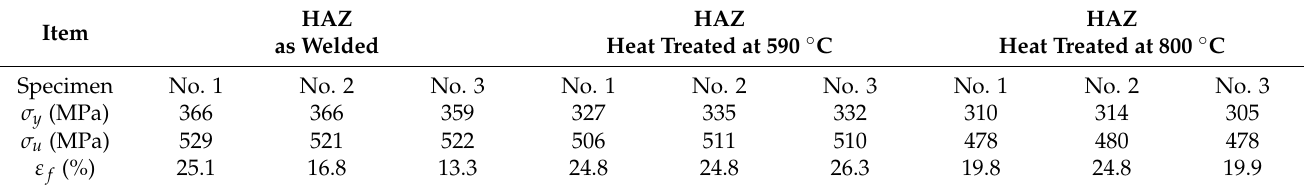
Table 2. Yield strength, tensile strength, and elongation rate of the HAZ